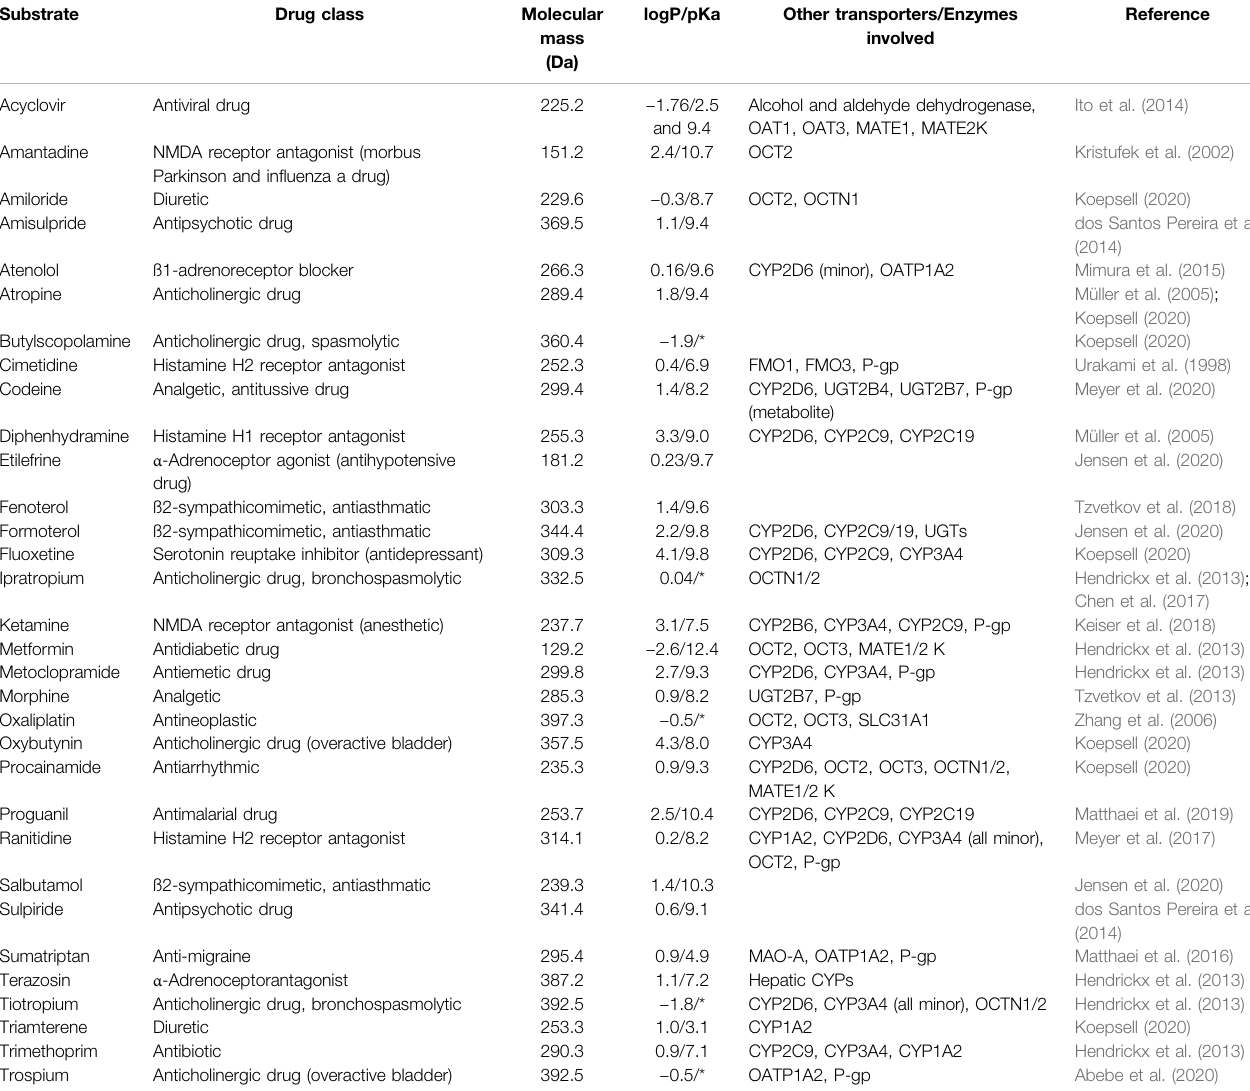
TABLE 1 | Overview of clinically relevant drugs described to be substrates of human OCT1 and their physicochemical properties as obtained from DrugBank (https://go. drugbank.com). If available, experimental data have been preferred over predicated data (*permanent cations, no pKa available).